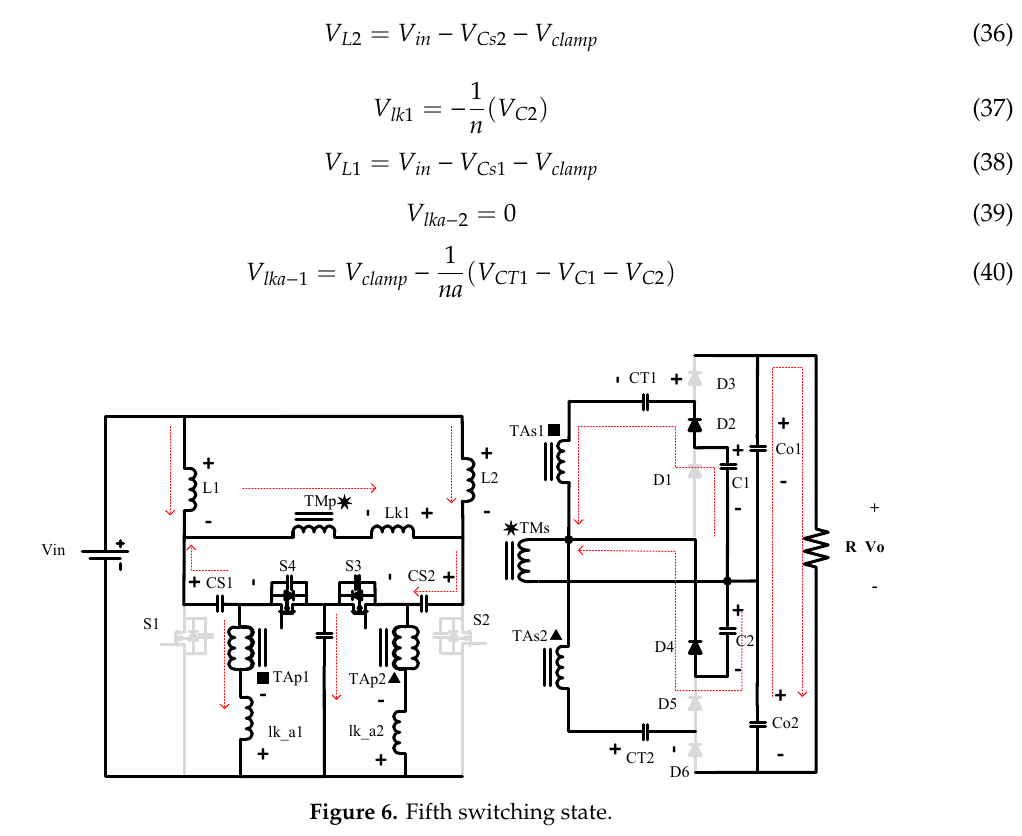
Figure 6. Fifth switching state.